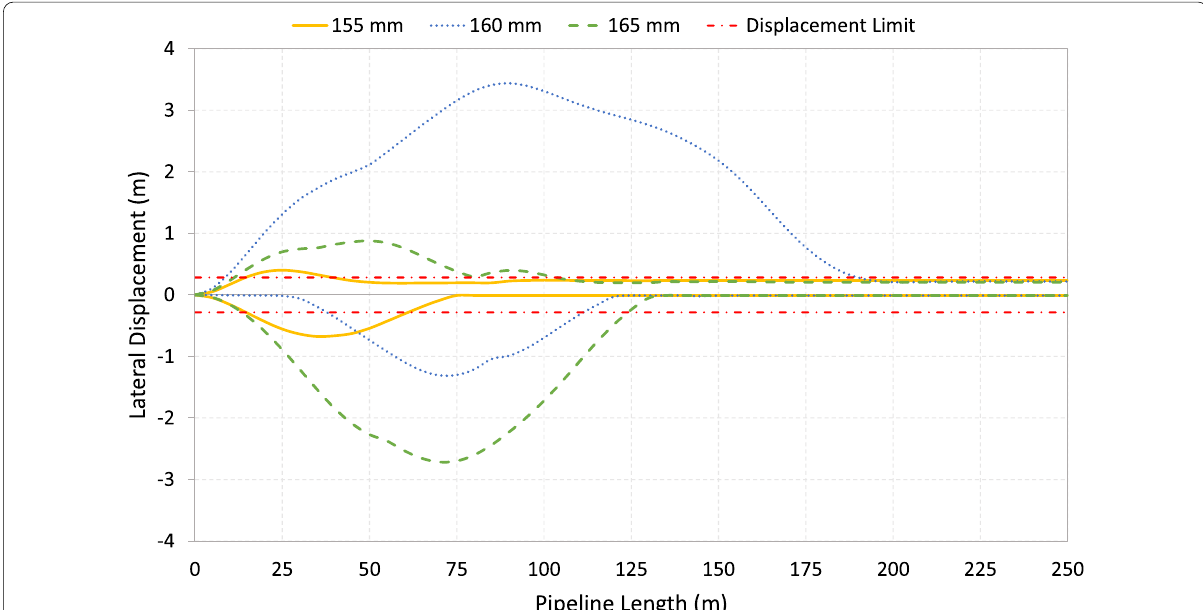
Fig. 7 Envelopes of the lateral displacements of the pipeline for concrete thickness range 155–165 mm (10-year RPV wave